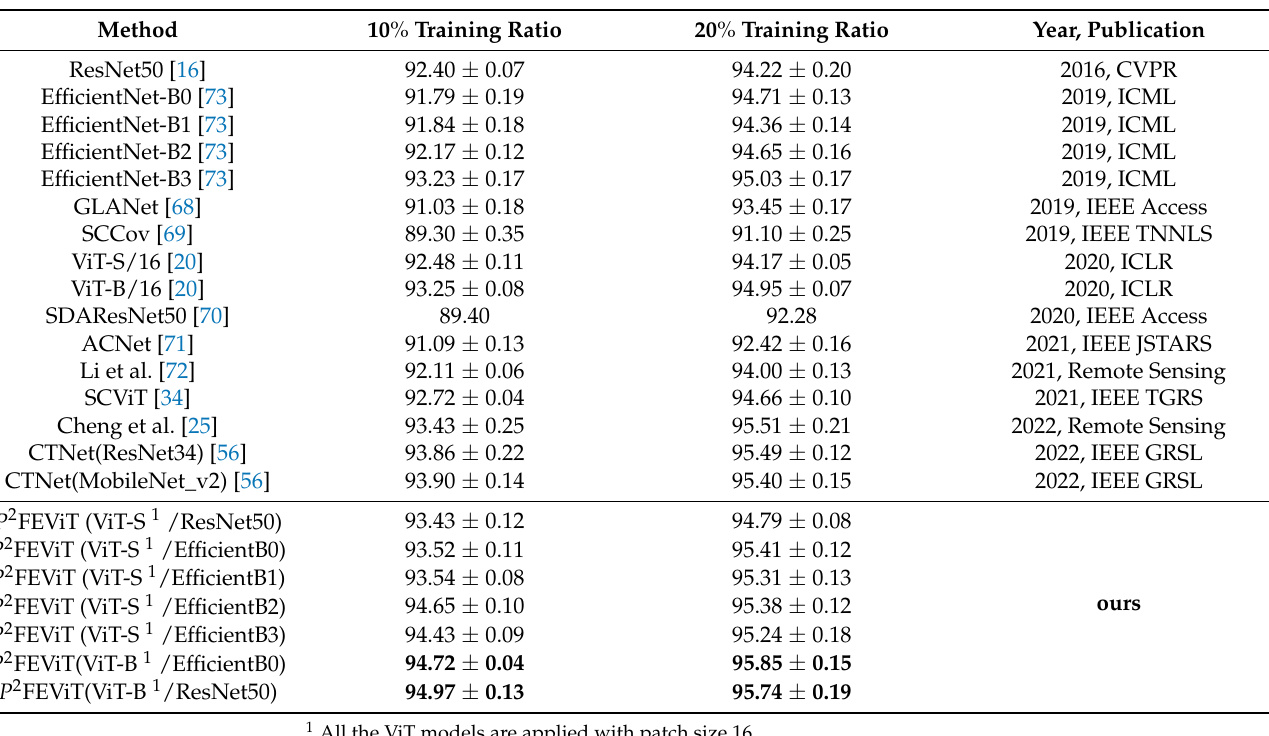
Table 2. Overall accuracy (OA) of comparison SOTA methods under different training ratios on the NWPU-R45 dataset.